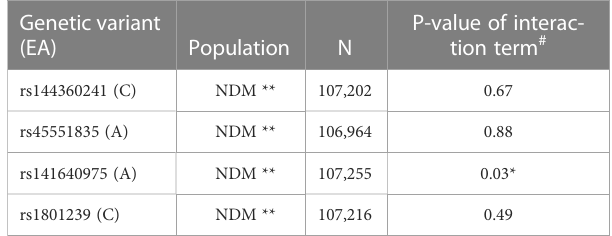
TABLE 7 Summary results for GRS CUBN -eGFR creatinine and -ALB analyses in UKBB (model 3).